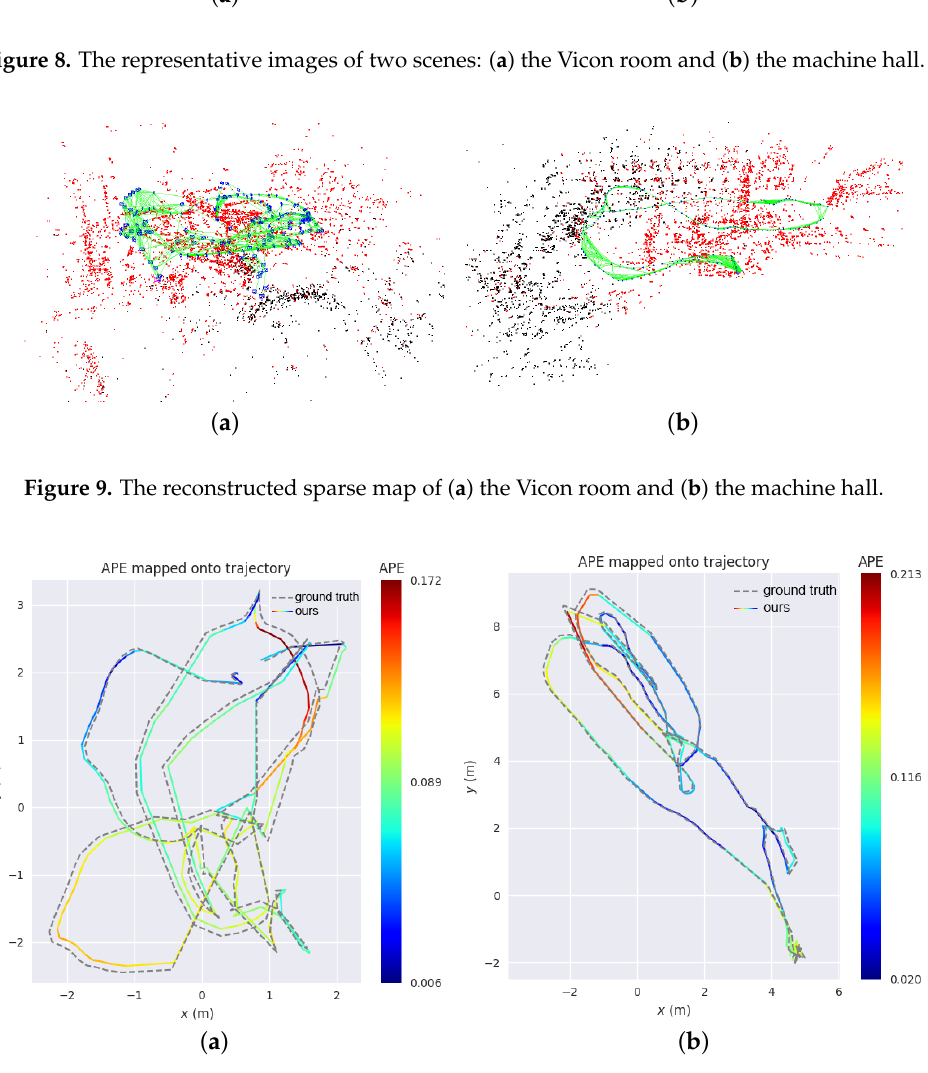
Figure 10. The trajectory of keyframes on sequences ( a ) V1_01_easy and ( b ) MH_01_easy of two scenes. The colorful trajectory is produced by combining our initial state estimation method with visual–inertial ORB-SLAM2 back-end; the ground truth trajectory is provided by EuRoC dataset. The various colors express the range of the corresponding absolute pose error